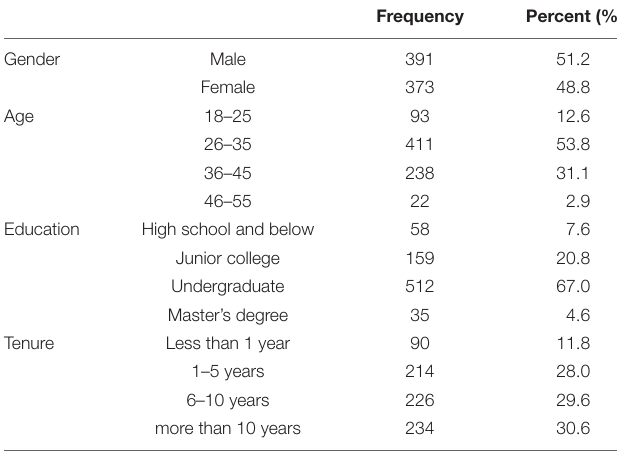
TABLE 1 | Data sample characteristics of